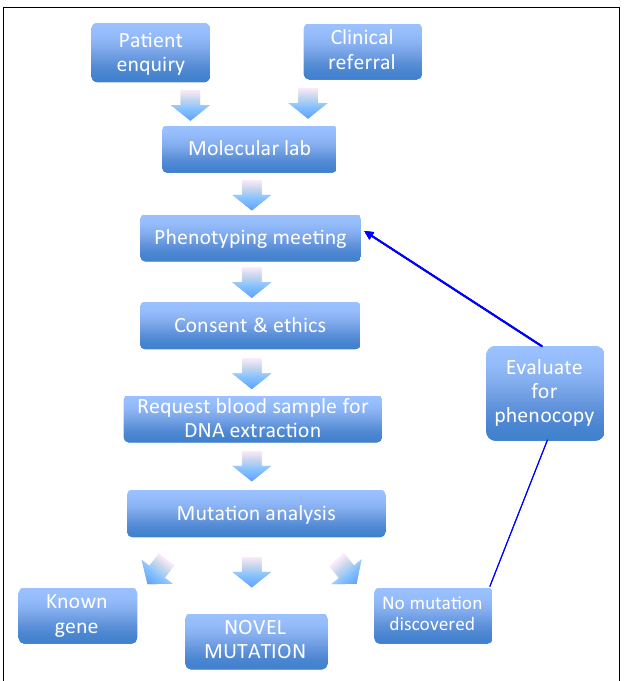
FIGURE 1 | Molecular genetic screening pipeline. This schematic diagram highlights the key stages involved in the clinical ascertainment and molecular genetic